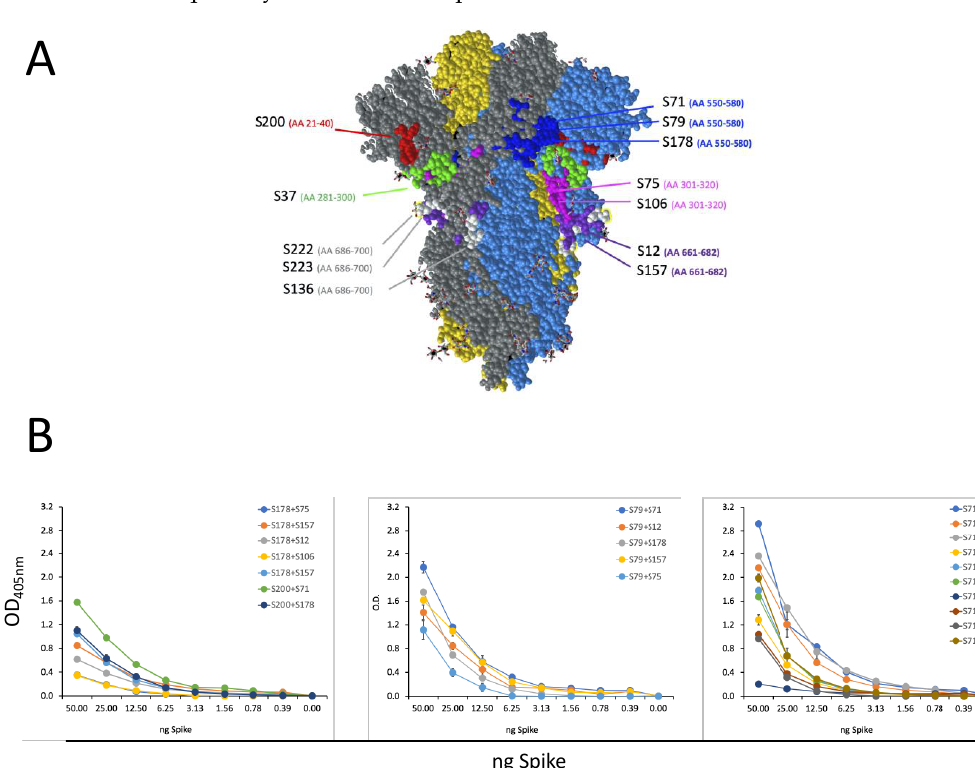
Figure 4. Characterization of epitope recognized by isolated S-specific mAbs. ( A ) Epitope map- ping on the 3D structure of trimeric spike protein (retrieved from PDB 6VXX, [9]). Each monomer of the trimeric spike is represented in grey, blue, or yellow, respectively. Different epitopes are evidenced with the corresponding color. ( B ) Sandwich ELISA with several pairs of mAbs for the detection of scalar doses of the recombinant spike protein. In the legends, the first indicated mAb is used as coating, and the second indicated mAb is used as secondary antibody. Error bars indicate the standard deviations of technical duplicates from a representative experiment repeated twice.